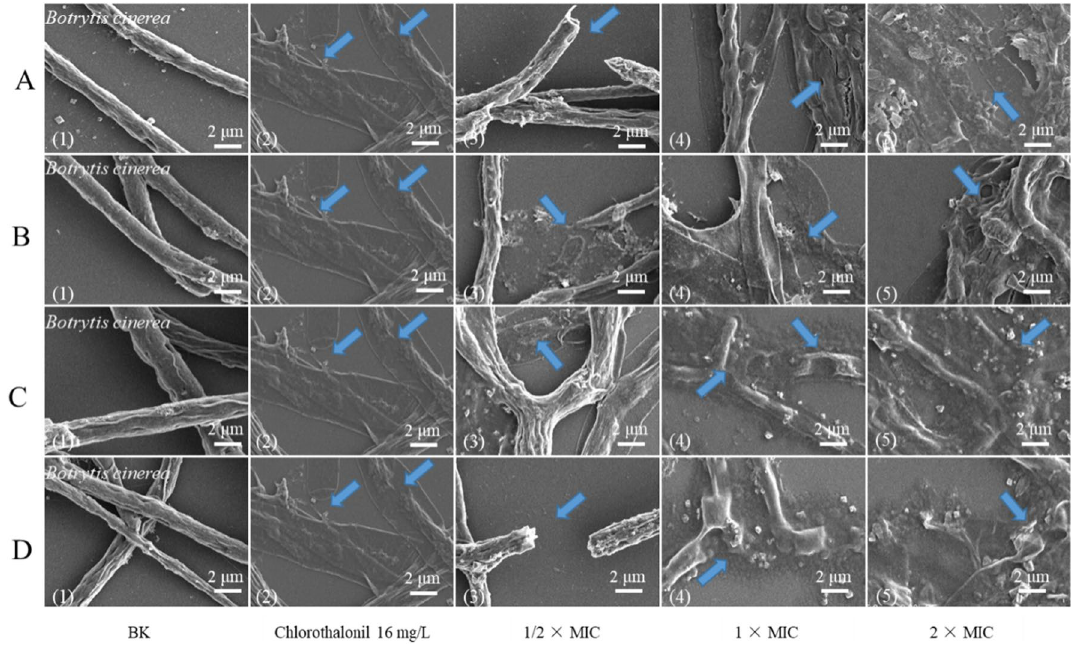
Fig. 3 SEM photos of B. cinerea untreated mycelium ( A1 – D1 ); mycelia treated with sinotumine I ( A ), reticuline ( B ), berberine ( C ) and jatrorrhizine ( D ) at 1/2 MIC, 1 MIC, 2 MIC ( A3 – D5 ); mycelium treated with chlorothalonil at 16 mg L − 1 ( A2 – D2 ). The blue arrow represents the observed × × × morphological